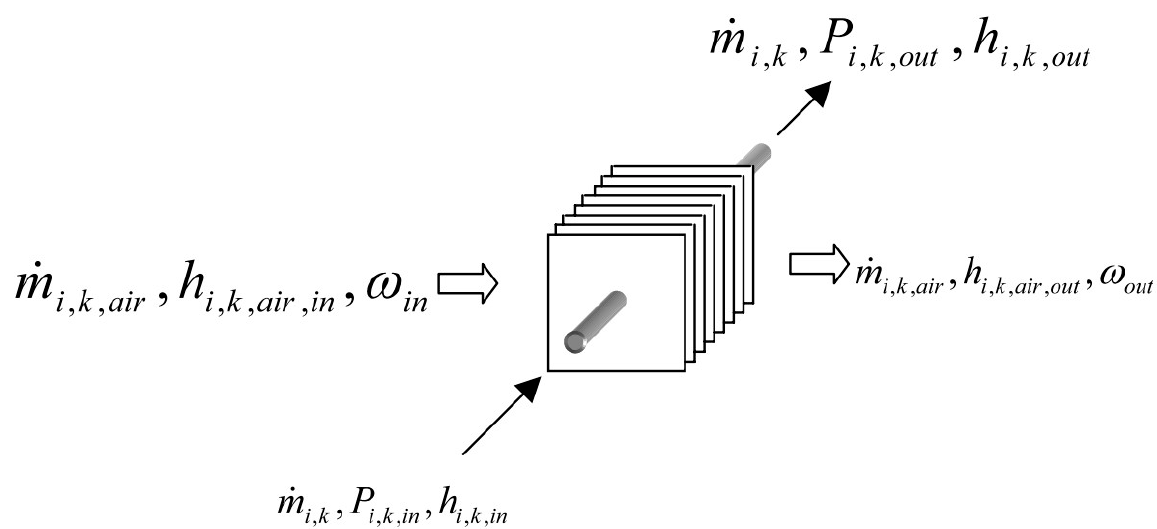
Figure 8. Segment as a single cross-flow heat exchanger [34].